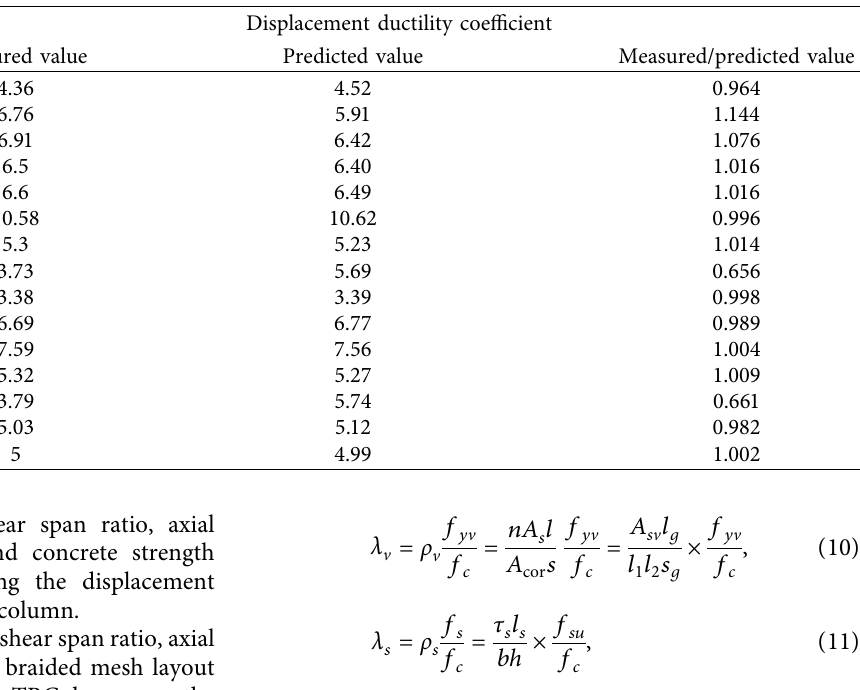
Table 7: Comparison of measured and predicted